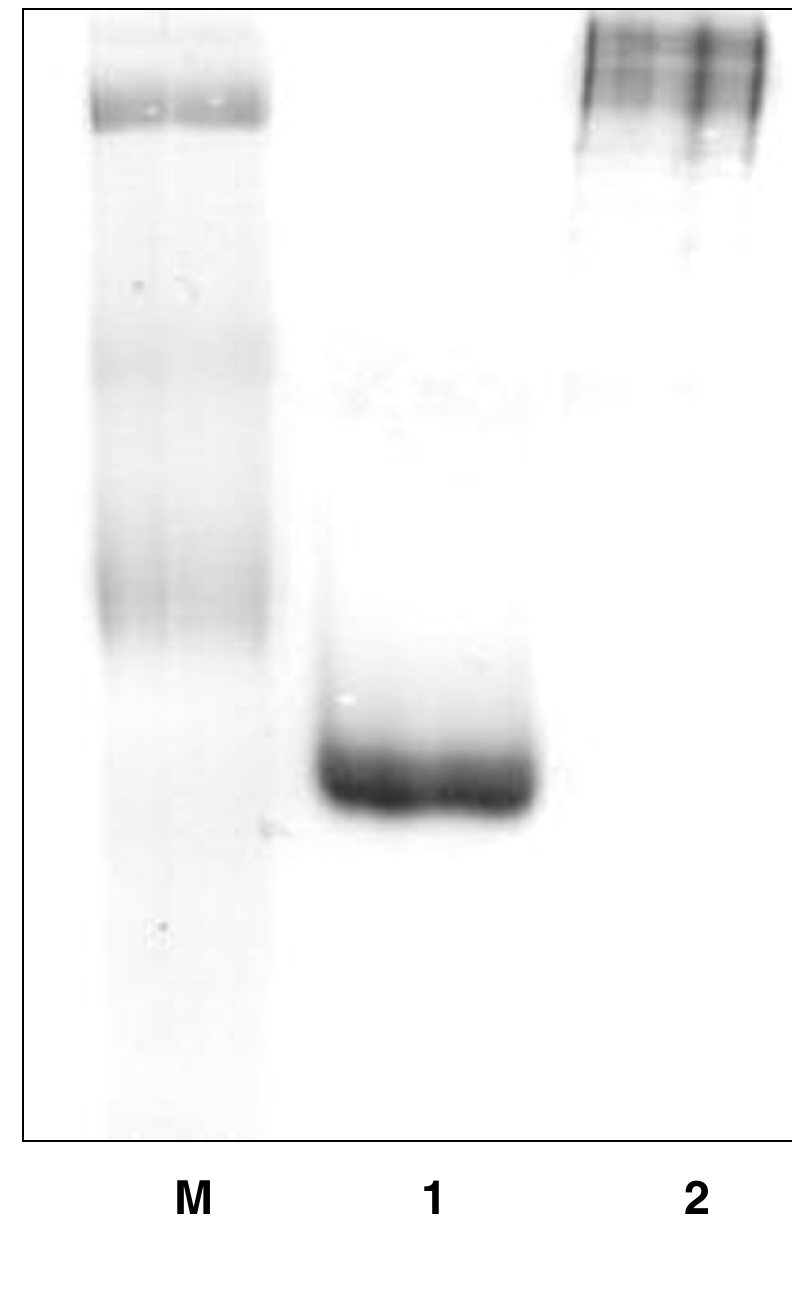
Figure 1 Native and polymerised AAT (10 µ g/ml) analysed by 7.5% native PAGE. Lane M, molecular size markers, lane 1, native AAT and lane 2, polymerised AAT (incubated at 60°C, 3